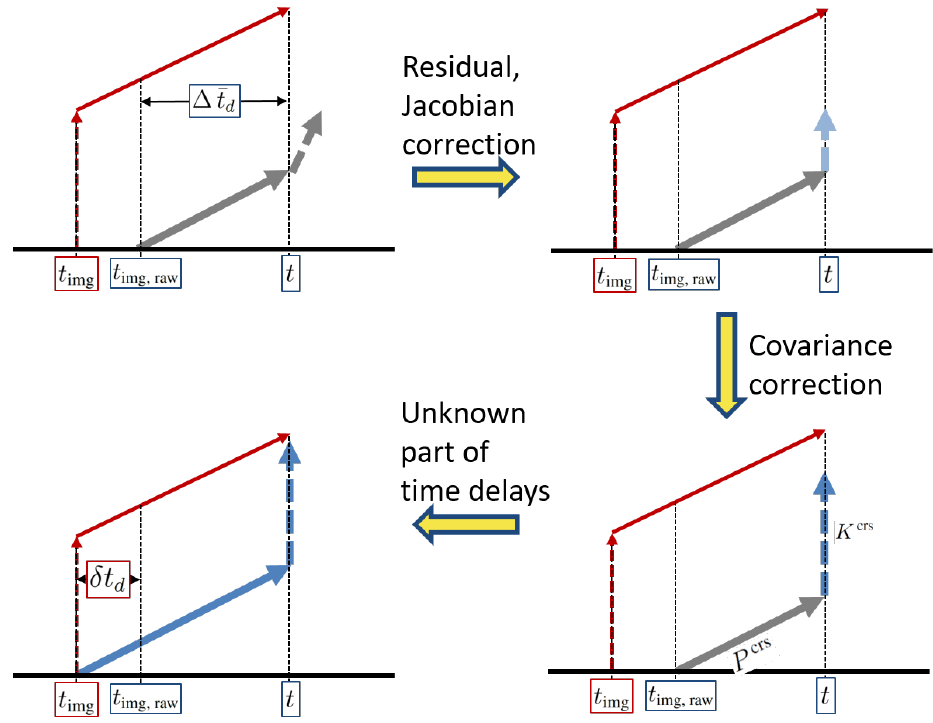
Figure 5. Three corrections in the latency compensated